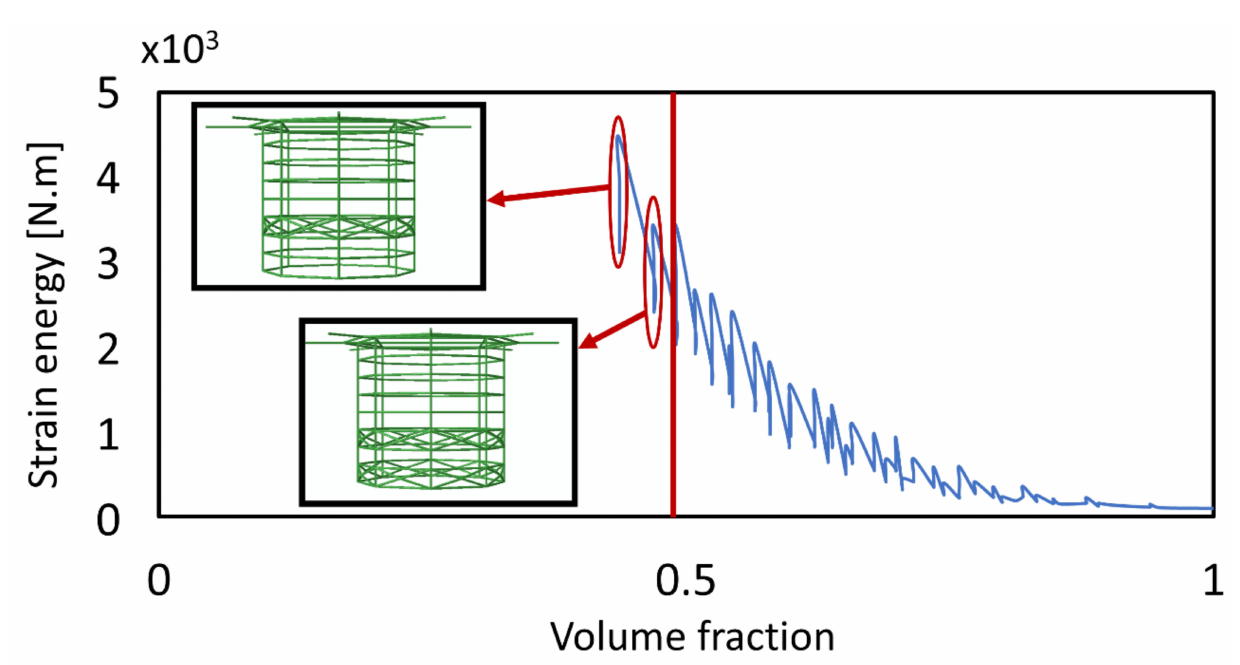
Figure 20. Volume fraction of the design space. Examples of the structures with the volume fraction lower that 0.5 are shown